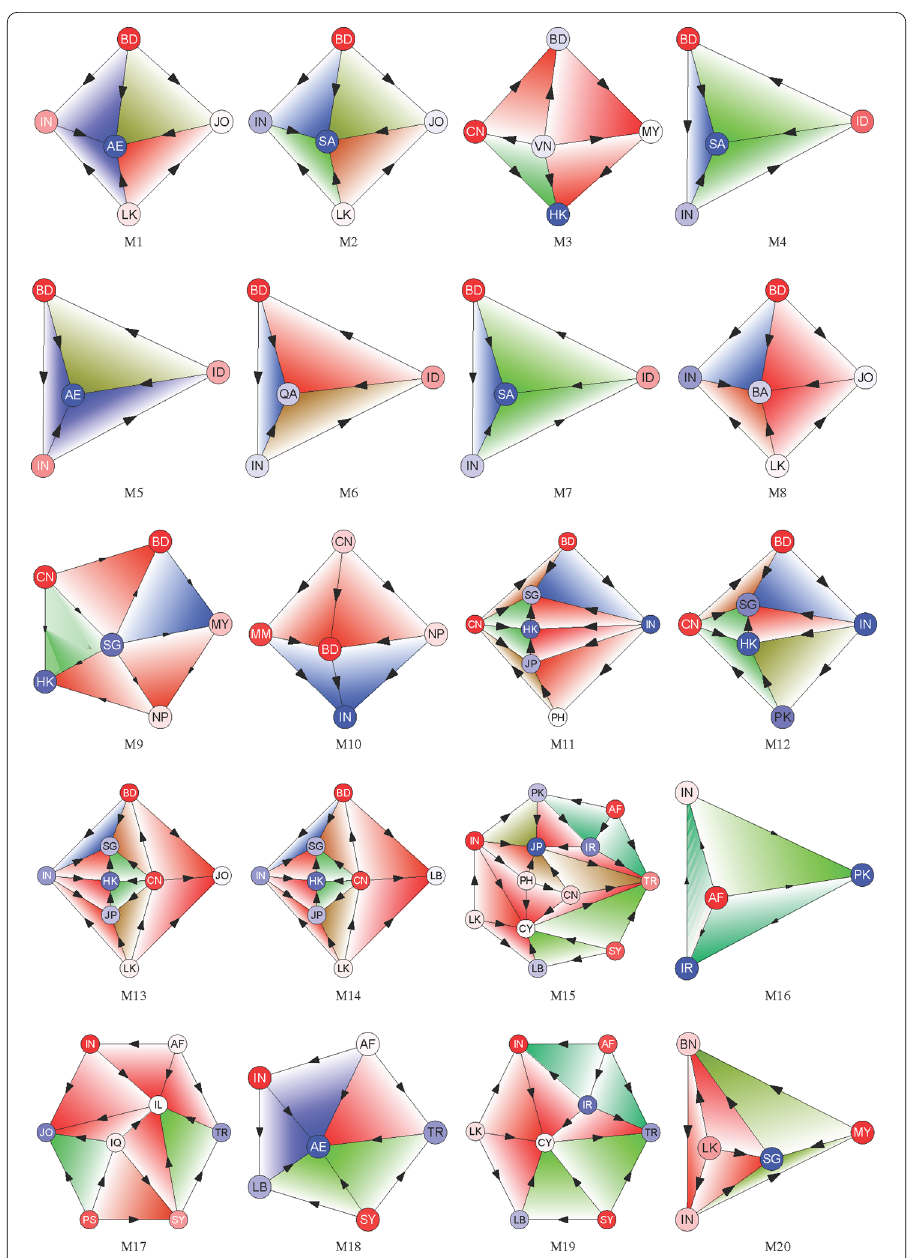
Figure 12 Spherical patterns within the Asian migration and Remittance networks. 2-cycle generators for the 2015 Asian net migration (M1-M37) and remittance (R1-R42) networks